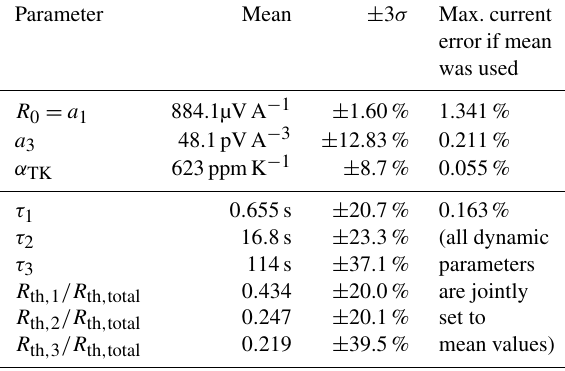
Table 6. Arithmetic mean and variance of the calibration parame- ters for 100 test systems. The last column lists the maximum current error if the mean value instead of the actual value of the respective parameter was used for error